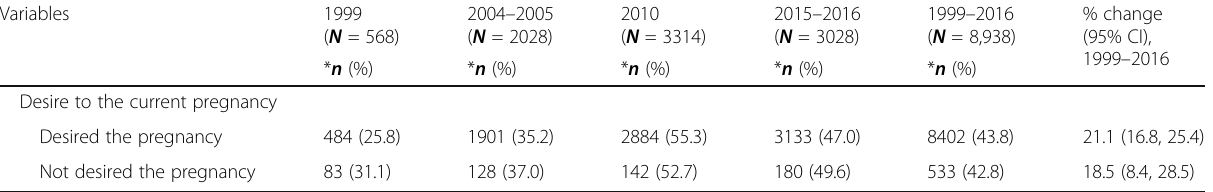
Table 2 Prevalence of one to three antenatal care visits by the study factors in Tanzania, 1999 – 2016 (Continued)